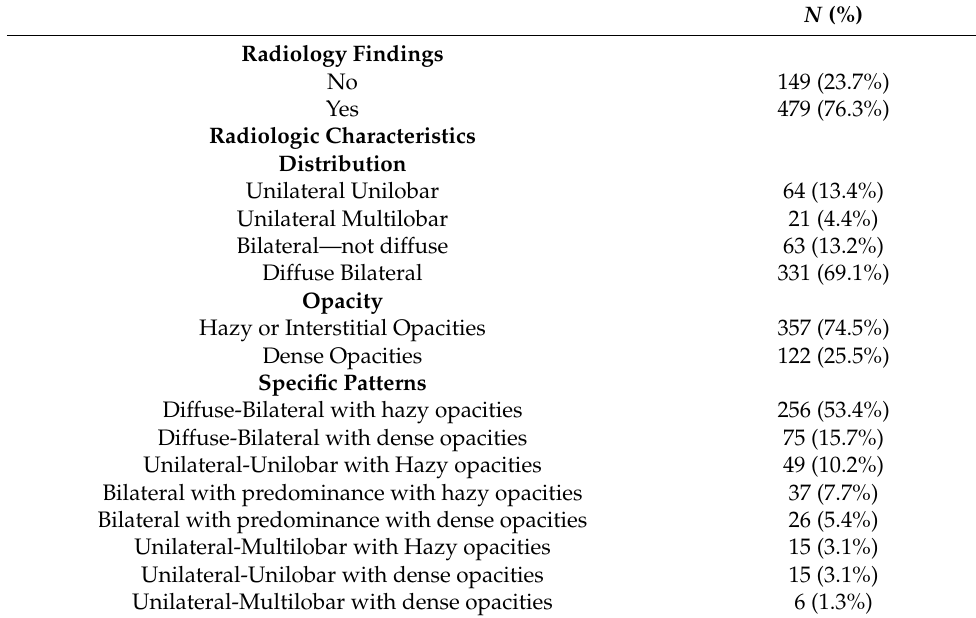
Table 2. Distribution and frequency of radiographic findings.